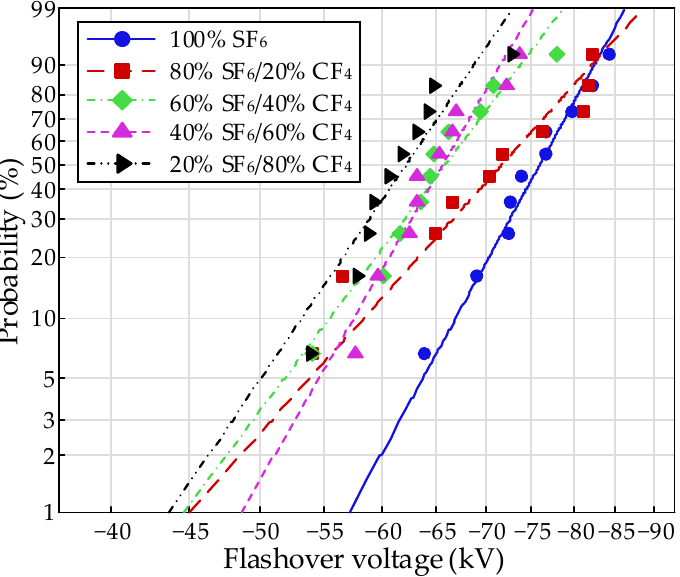
Table 1. Shape and scale parameters with a finger-type electrode system.